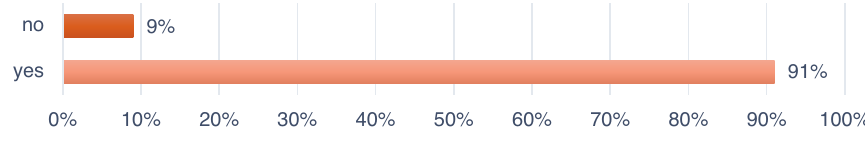
Fig. 2: Are your library’s strategic goals still broadly relevant and fit for purpose?